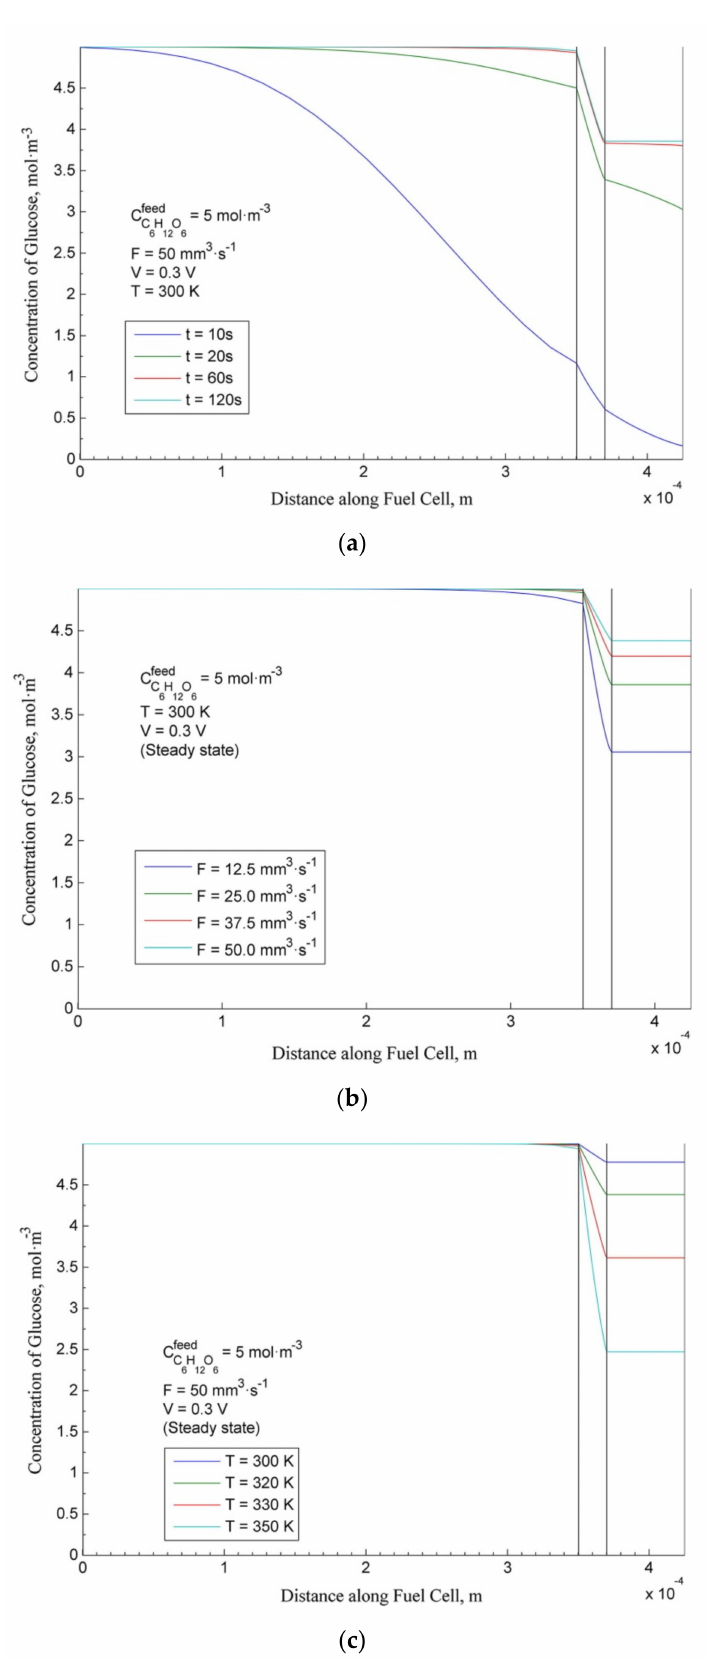
Figure 16. Variation of glucose concentration in the anodic enzymatic half-cell as function of time ( a ), flow rate ( b ) and temperature ( c ). Reprinted from [51], with permission from